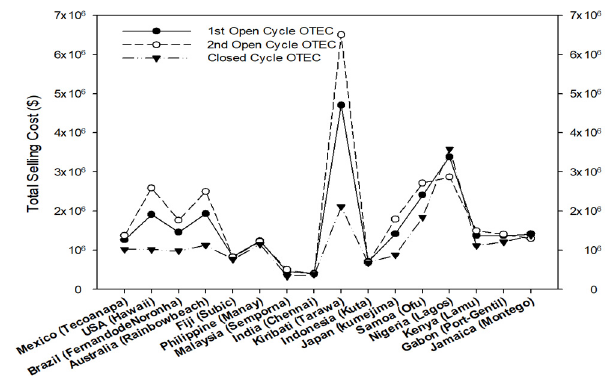
Figure 9. Total selling costs for OC- and CC-OTEC in application areas.